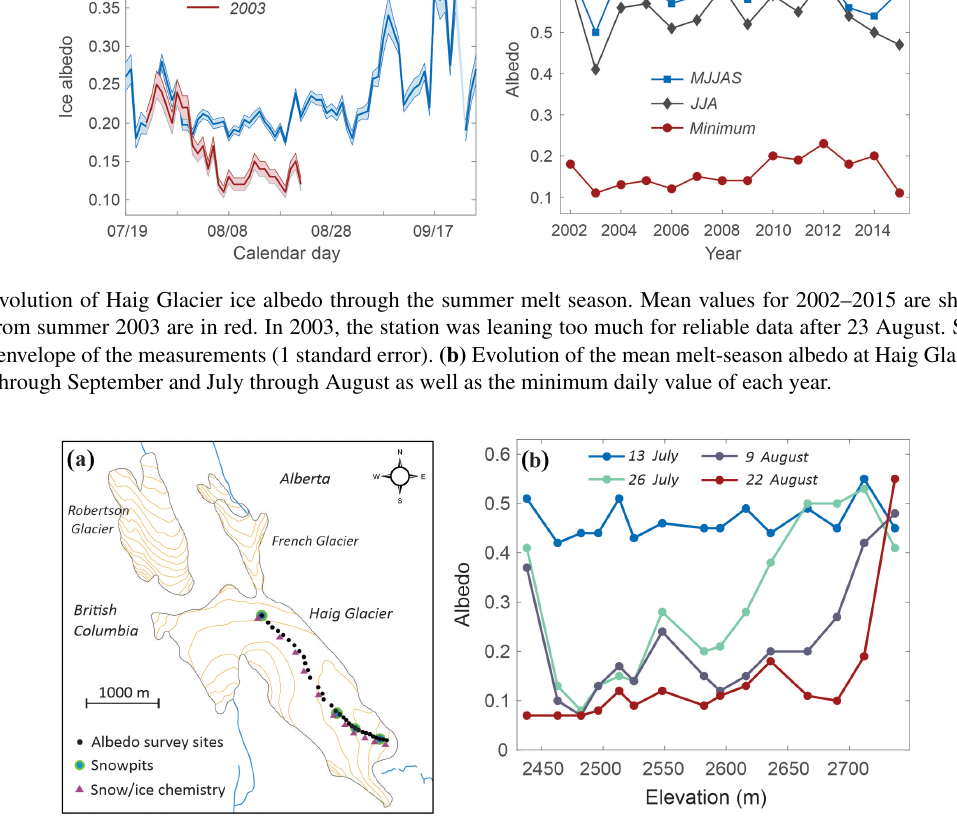
Figure 7. (a) Black circles show the 33 survey sites for winter mass balance and albedo measurements along the Haig Glacier “centreline” transect. (b) Evolution of surface albedo along the centreline transect during four visits in July and August 2017.